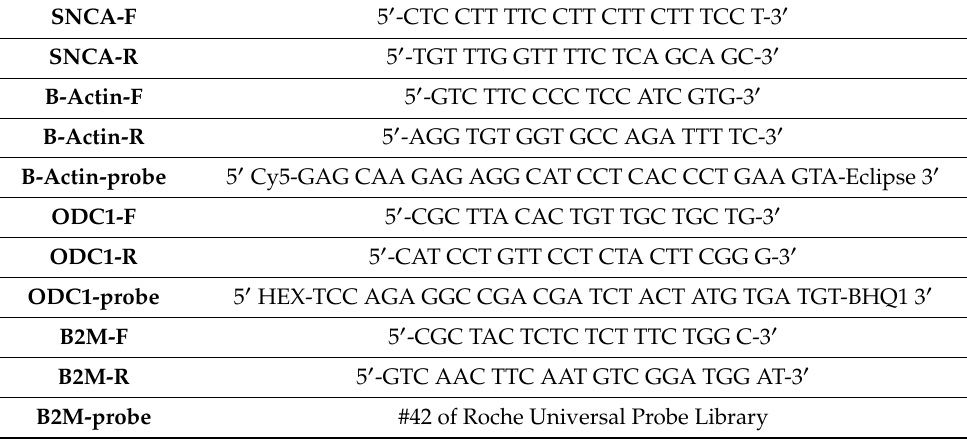
Table 3. Sequences of oligonucleotides